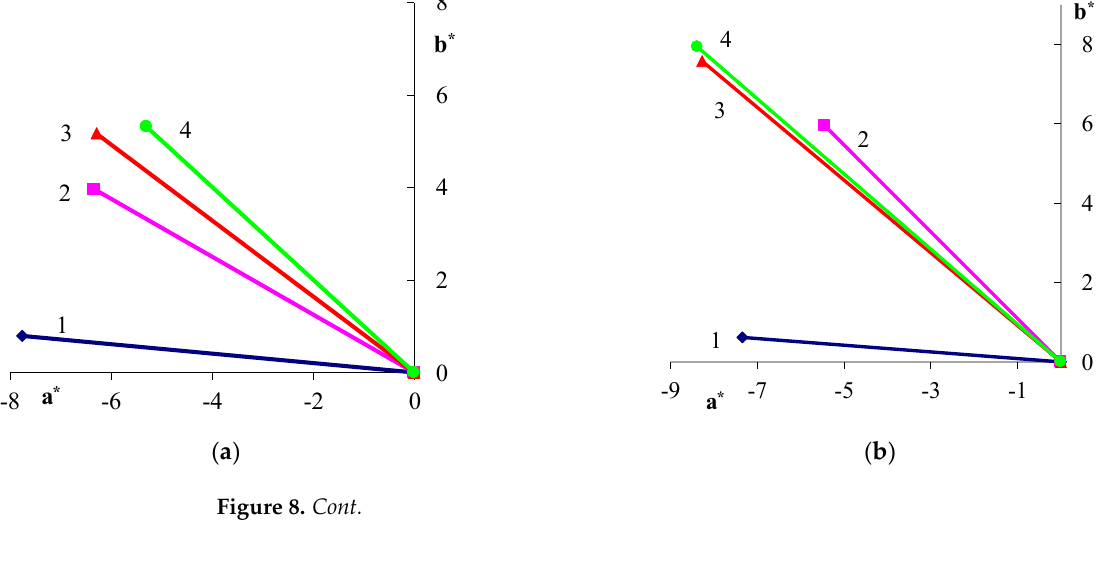
( d ) Figure 8. Color vector projection of core/shell pigment based on talc and doping acid: ( а ) Н 2 SO 4 ; ( b ) НСl; ( c ) H 3 PO 4 ; ( d ) undoped PANi on the СIЕL*a*b* color plane. PANi content in the core/shell pigment (wt.%): (1)—5; (2)—20; (3)—33; (4)—50. Hiding power is another important optical property of pigment. This property, for PANi-coated core/shell pigments, depends on the polymer content in the pigment only and has no relation to the doping acid used in the synthesis. Core/shell pigment hiding power grows with an increase in PANi content (Figure 9). It should be noted that the hid- ing power is comparable to that of pure PANi, even at a 50 wt.% of core/shell pigment content, with a shell of phosphoric-acid-doped PANi.